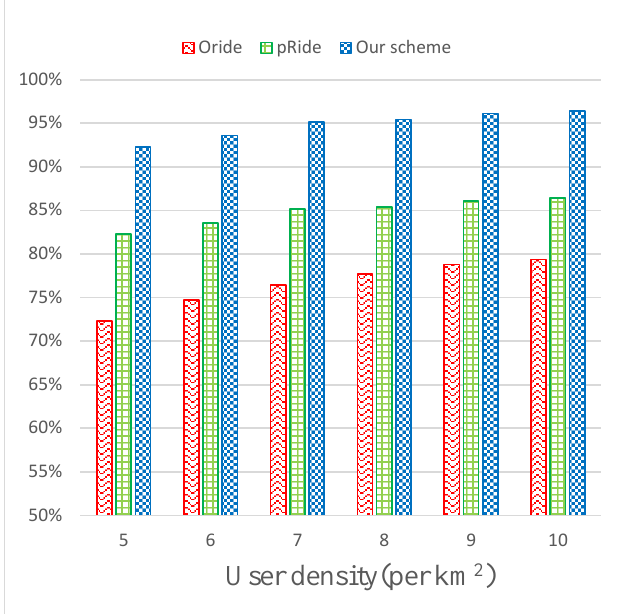
Figure 6. Matching accuracy under different user